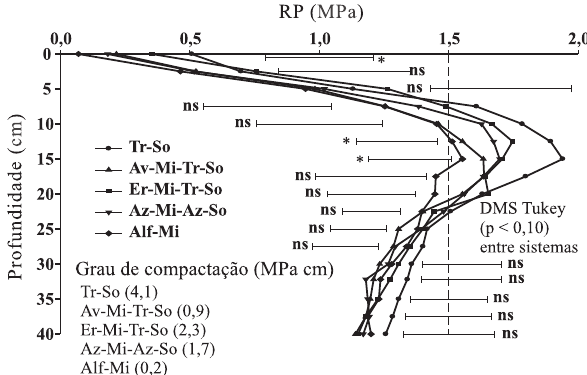
Figura 5. resistência mecânica do solo à penetração (rp) e grau de compactação de um latossolo Vermelho sob sistemas de culturas em plantio direto. tr-so: trigo-soja; av-Mi-tr-so: aveia- milho-trigo-soja; er-Mi-tr-so: ervilhaca- milho-trigo-soja; az-Mi-az-so: azevém-milho- azevém-soja; alf-Mi: alfafa-milho. Barras horizontais representam a diferença mínima significativa pelo teste de tukey (p < 0,10) (ns: não significativo; *: significativo a 10 %). o grau de compactação (Mpa cm) é dado pela integração da área do gráfico que possui rp superior a 1,5 Mpa, considerado como